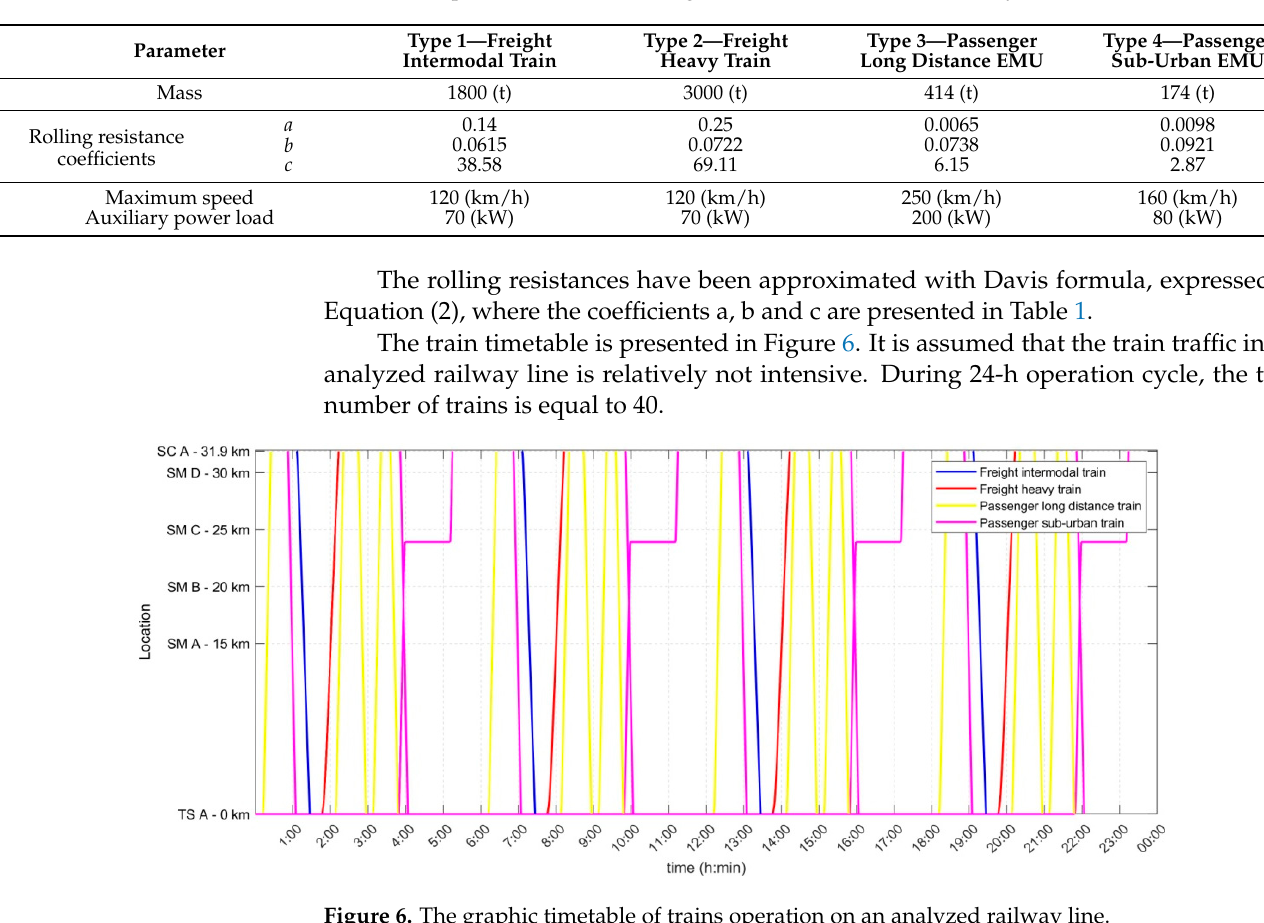
Figure 5. The traction characteristics and rolling resistances of the assumed in the case study rolling stock. Table 1. The parameters of the rolling stock assumed in the case study.